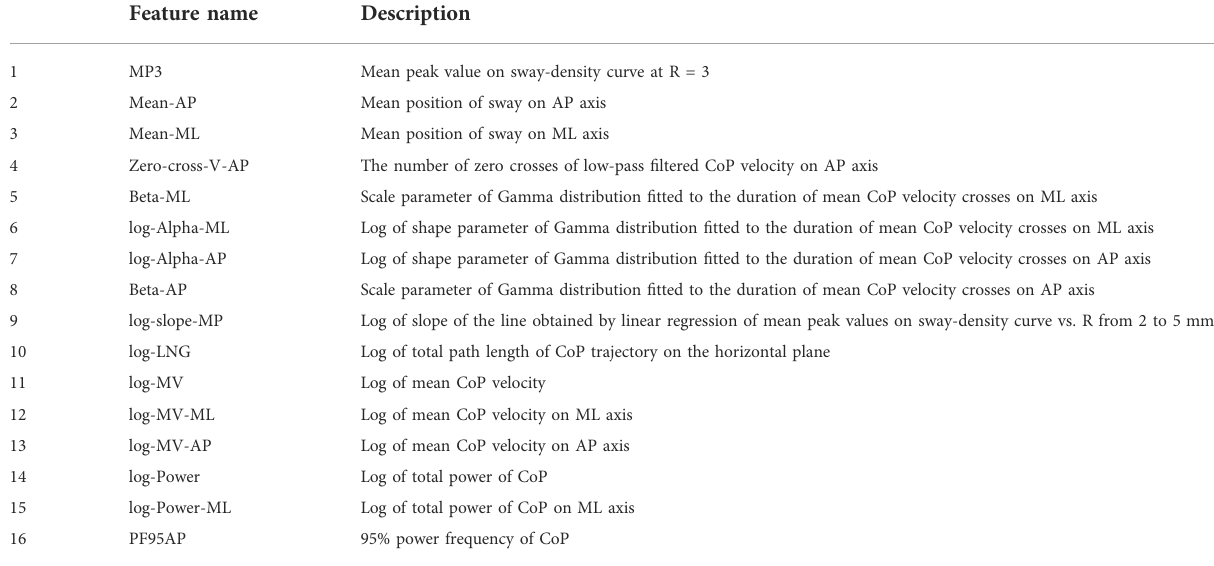
TABLE 1 The list of the 16 features that were extracted from the postural signal to characterize time-series of the center of pressure. A detailed description of the postural features, including their computation and their descriptive statistics, is provided in Supplementary Material (see Section Computation of postural features and Supplementary Table